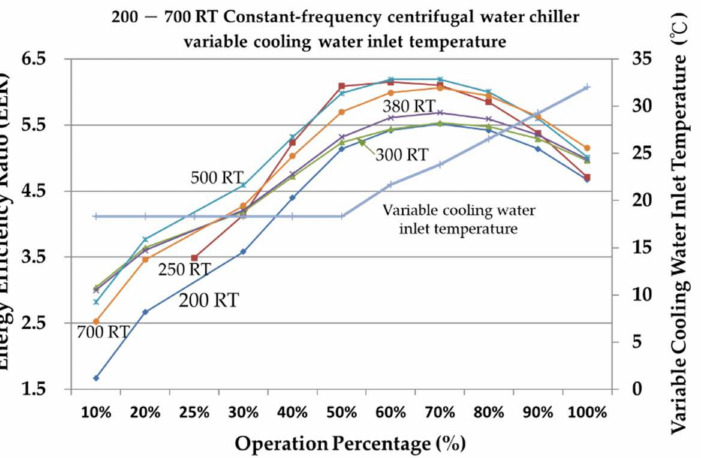
Figure 14. Variable-cooling water inlet temperature EER of the 200–700 RT constant-frequency water